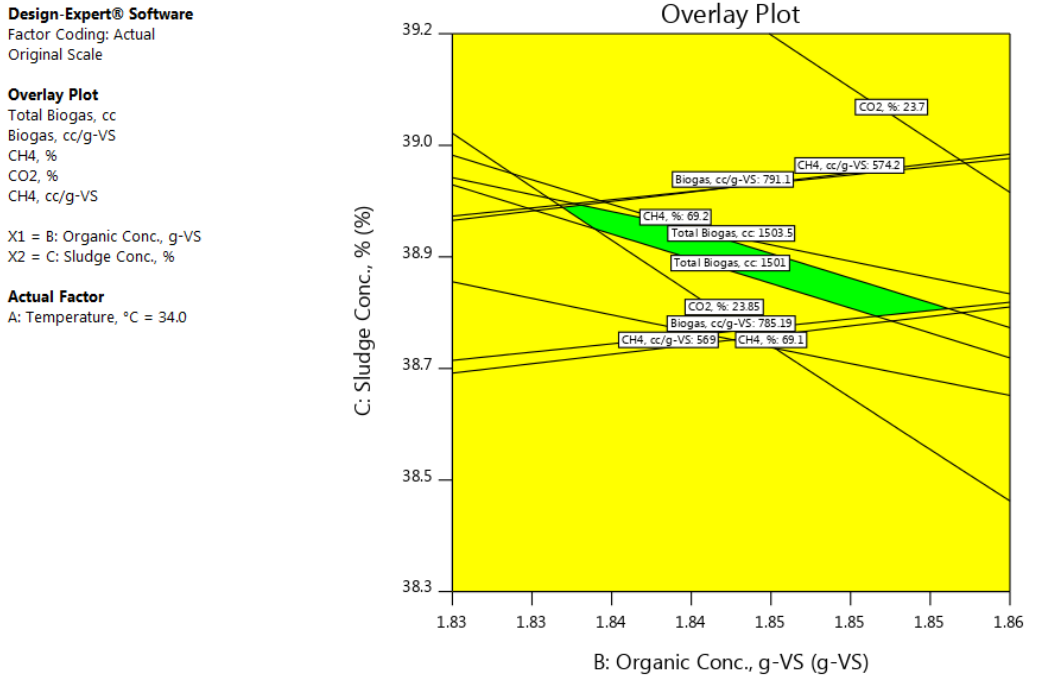
Figure 14. Overlay plot shows the optimum biogas based on the second criterion.